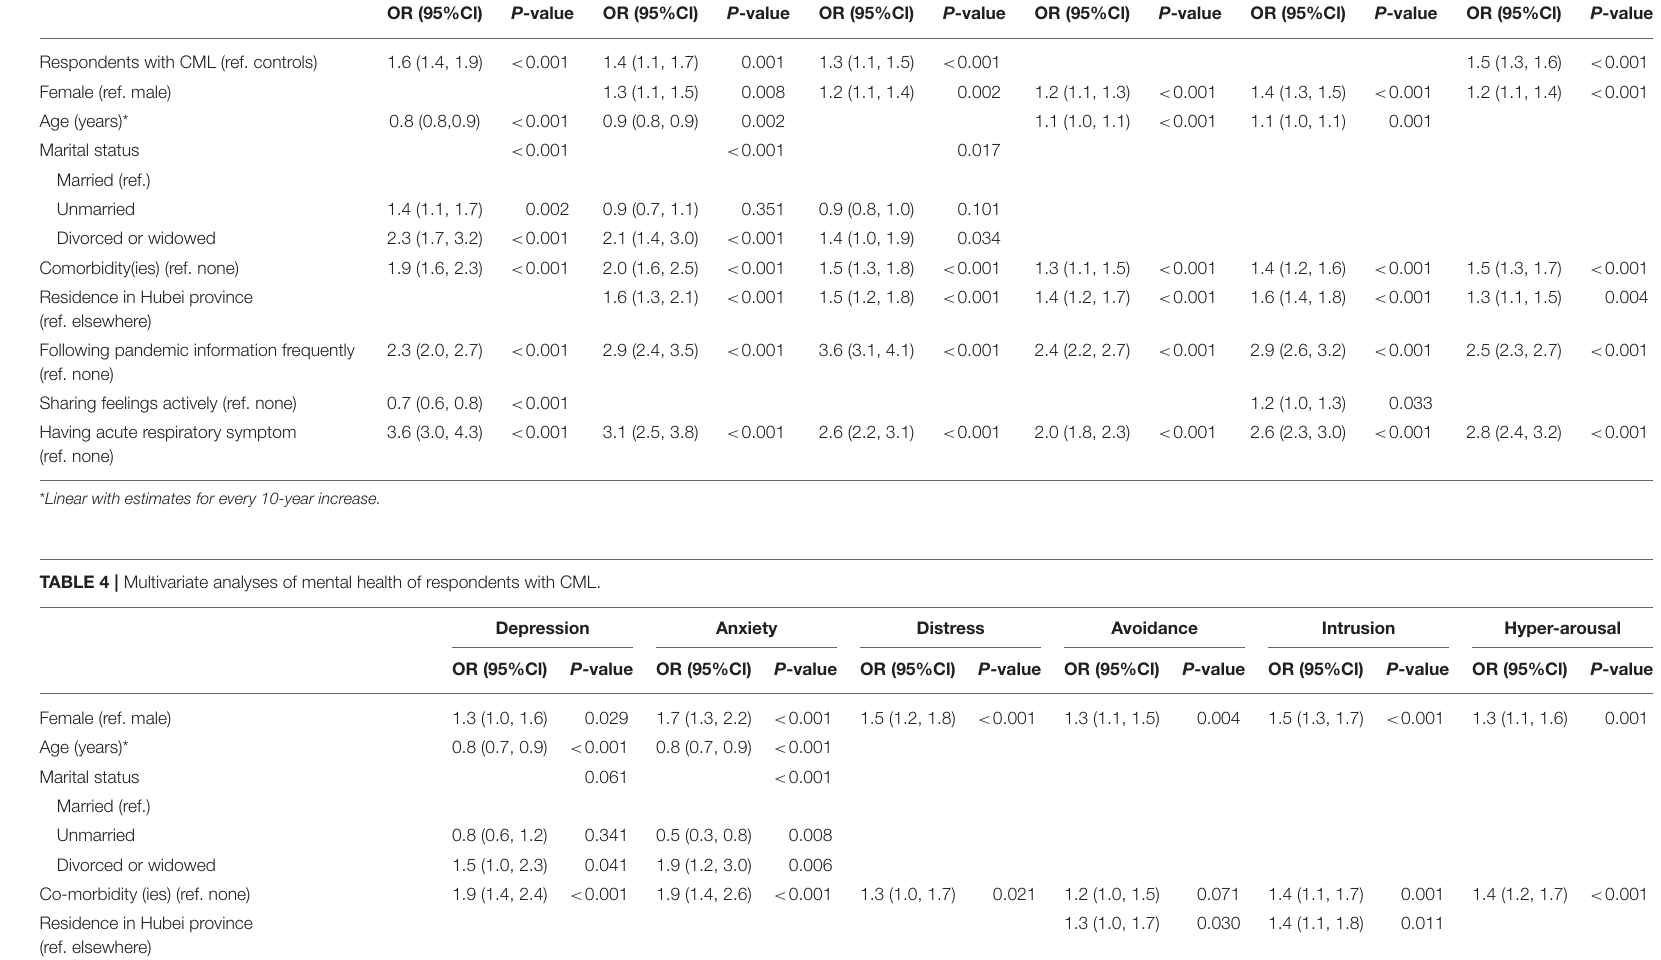
TABLE 3 | Multivariate analyses of mental health of respondents with CML and controls. Depression Anxiety Distress Avoidance Intrusion Hyper-arousal OR (95%Cl)